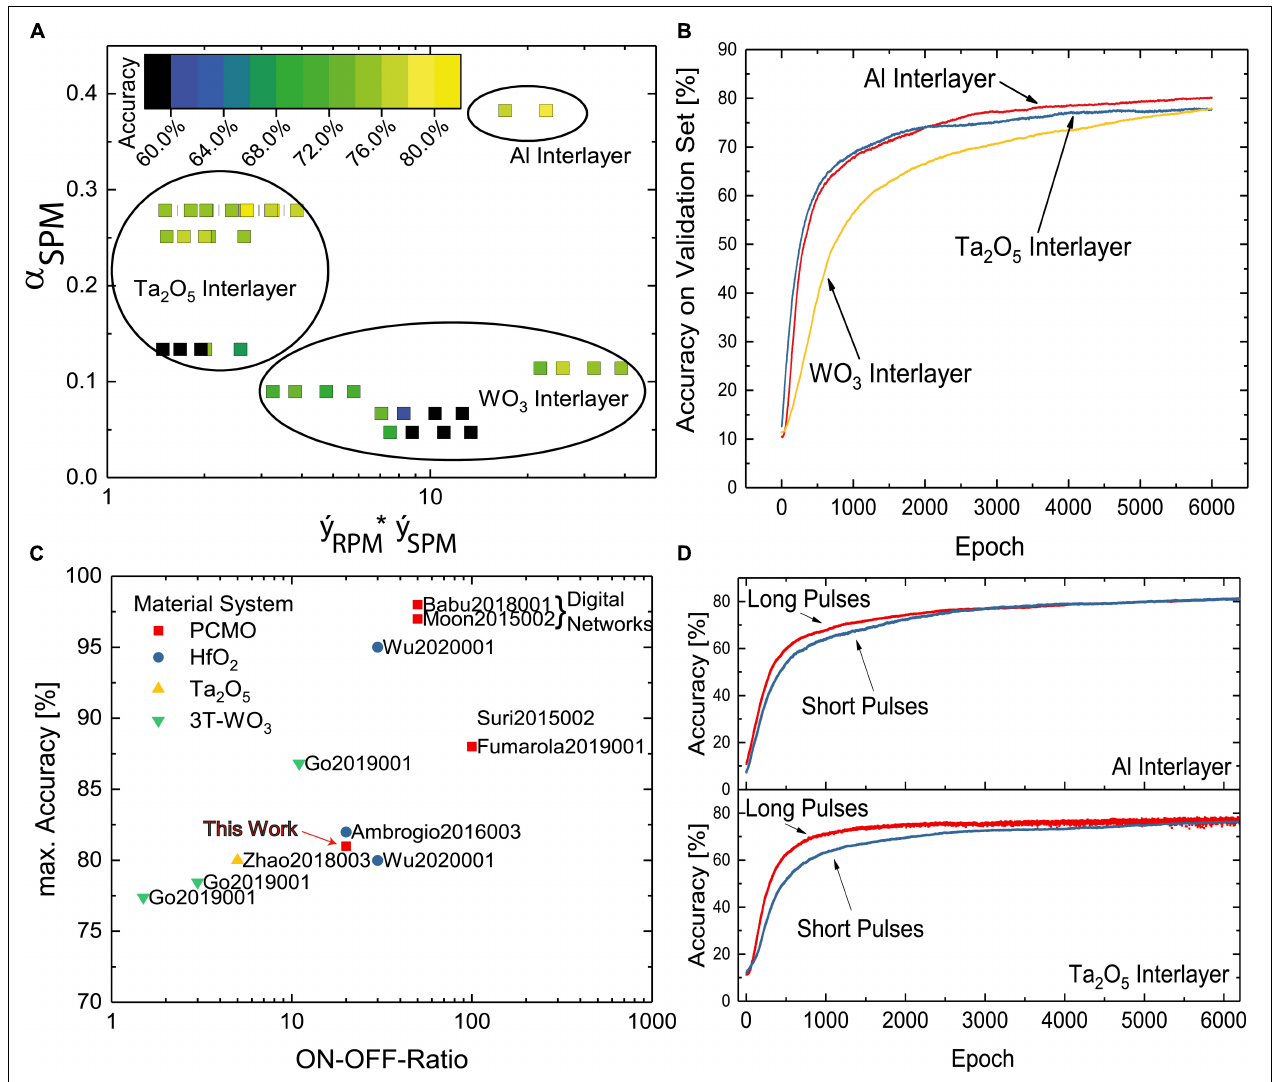
FIGURE 6 | Results of the neural network simulations. (A) Recognition accuracy of the simulated network depending on the fitted ON/OFF ratio and the steepness of the SPM fit function. (B) Network recognition accuracy on a subset of the MNIST dataset. Red: Al interlayer. Blue: Ta 2 O 5 interlayer. Yellow: WO 3 interlayer. (C) Recognition accuracies of similar networks with ReRAM devices from literature depending on the ON-OFF ratio of the used ReRAM devices (Moon et al., 2015; Suri et al., 2015; Ambrogio et al., 2016; Babu et al., 2018; Fumarola et al., 2018; Go et al., 2019; Wu et al., 2020; Yin et al., 2020). (D) Learning curves for PCMO devices with Al and Ta 2 O 5 interlayers with 100 µ s (red) and 1 µ s update